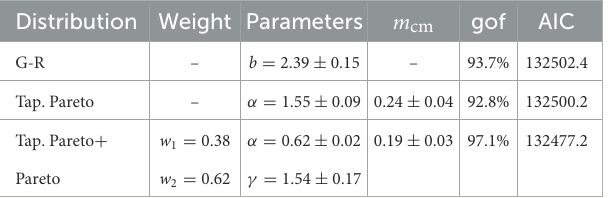
TABLE 2 The estimated model parameters with 95 % confidence intervals for the three frequency-magnitude models applied to the mining microseismicity with the events above magnitude m ≥ −